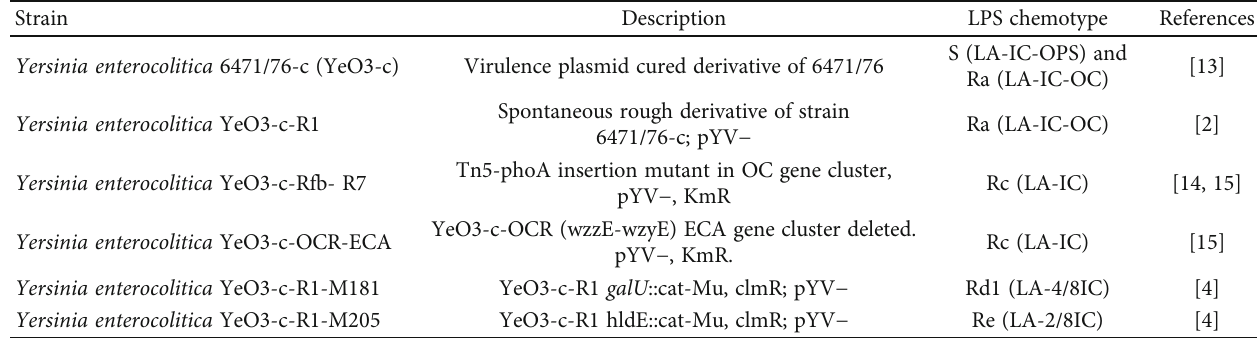
Table 2: Bacterial strains used in this work for isolation of LPS (c-cured of virulence plasmid pYV - ; R-O-antigen missing).